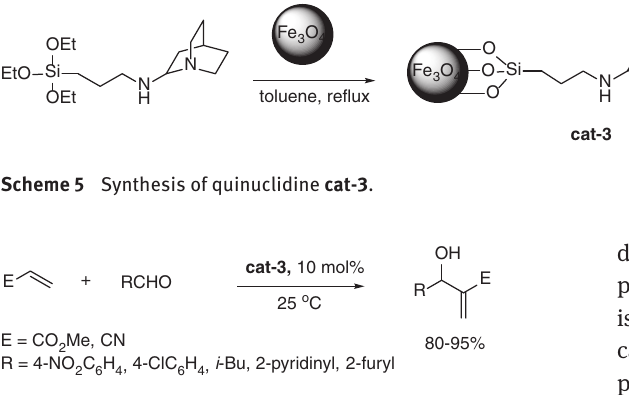
Scheme 6 MBH reaction promoted by cat-3.